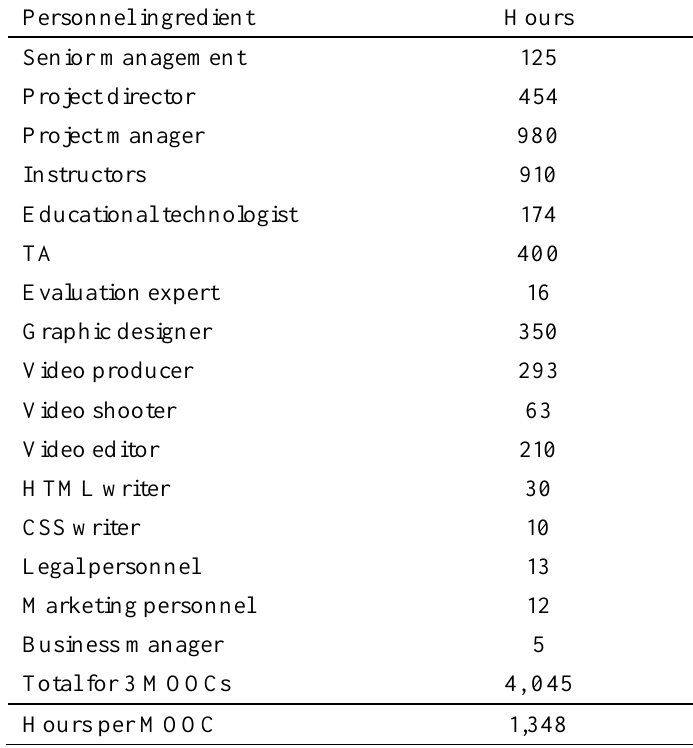
Hours Spent by AMNH Personnel to Develop Three MOOCs Personnel